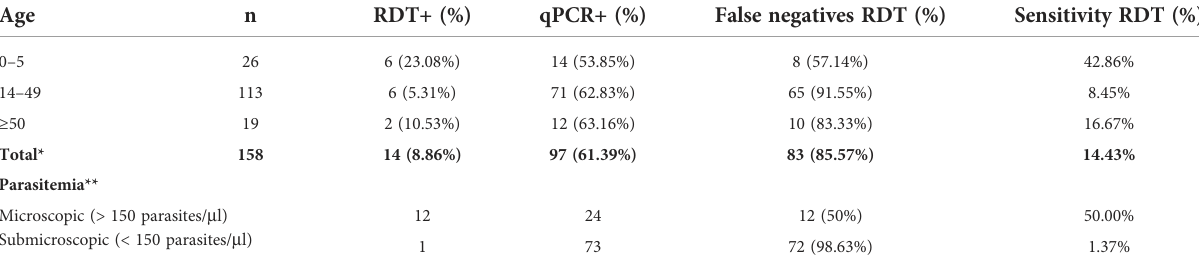
TABLE 2 Comparison of malaria status determination by RDT and